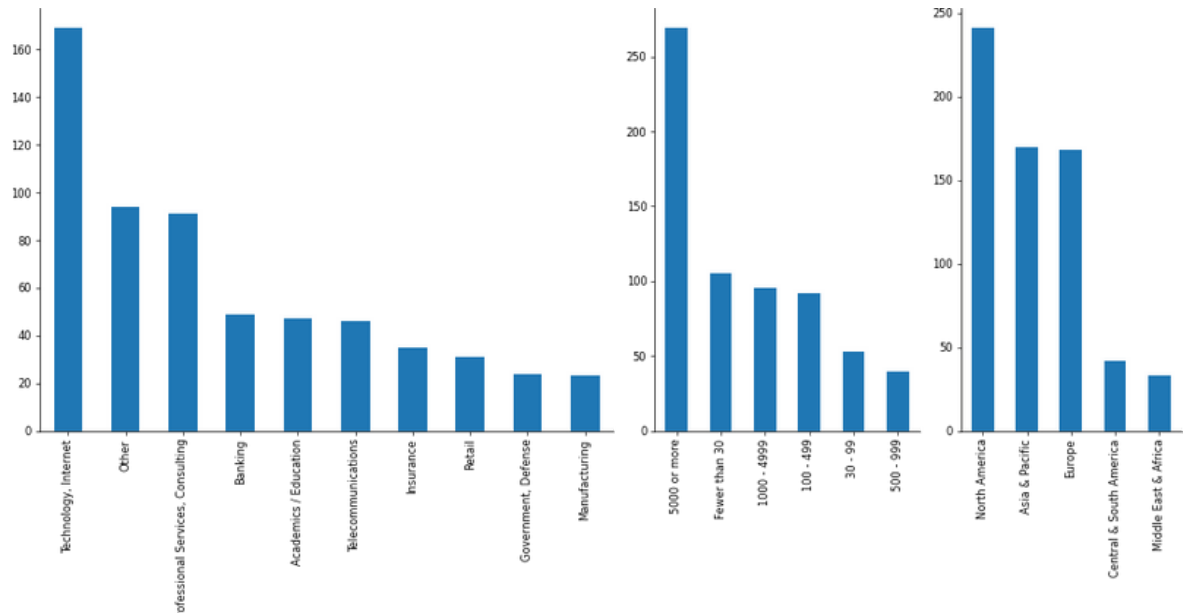
Figure 1 breaks down the respondents by industry (a), organization size (b), and geography (c).